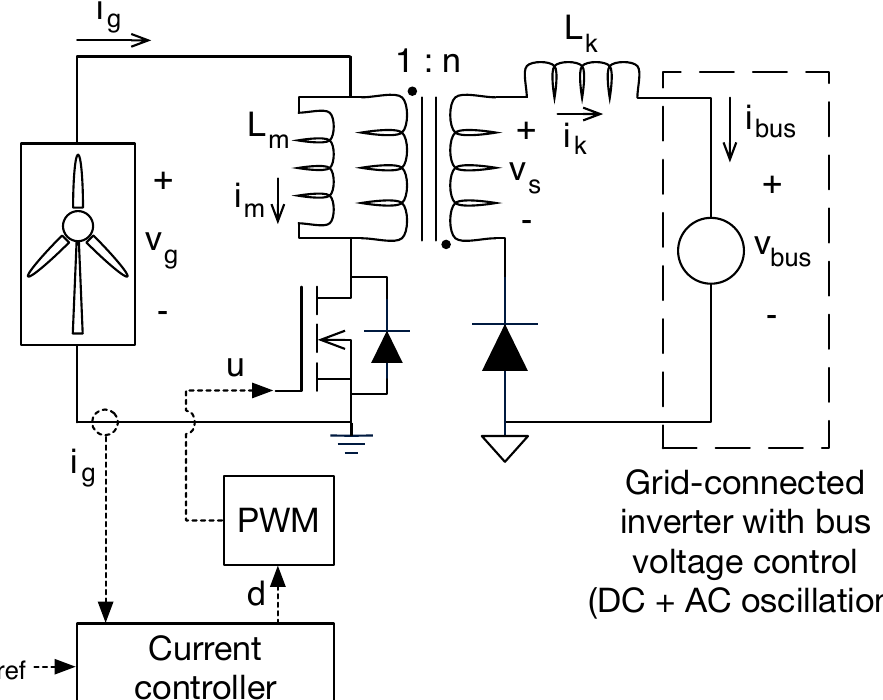
Figure 5. Circuital model of the flyback-based